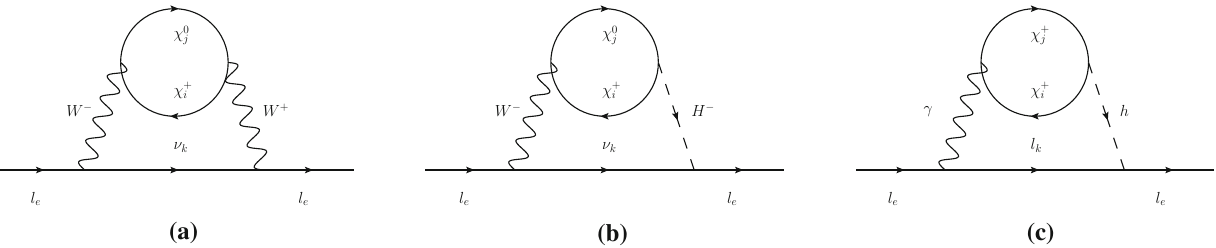
Fig. 2 Thetwo-loopBarr-ZeetypediagramsinwhichaclosedfermionloopisattachedtothevirtualgaugebosonsorHiggsfields,thecorresponding contributions to d e are obtained by attaching a photon to the internal particles in all possible